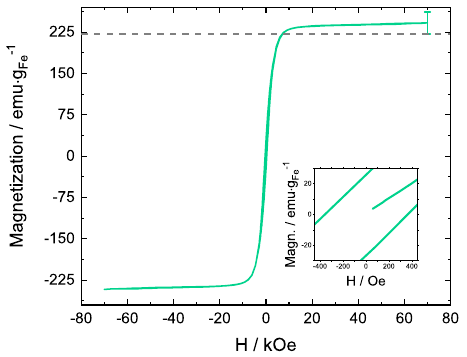
Figure 7. Magnetization versus applied field for Fe18wt.%-Ag measured at 300 K. The saturation magnetization is 240 ± 20 emu · g − 1 , the coercivity is 400 Fe